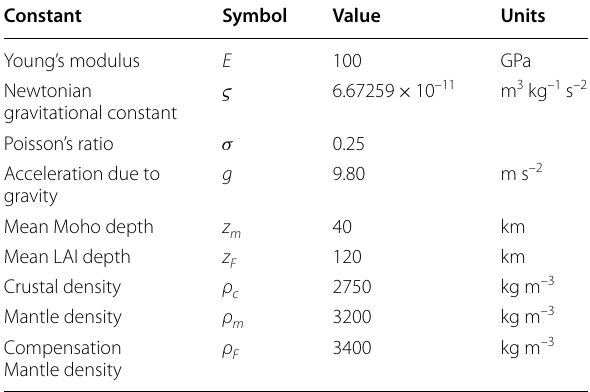
Table 1 Symbols and employed values for the model constants (revised from Kirby and Swain